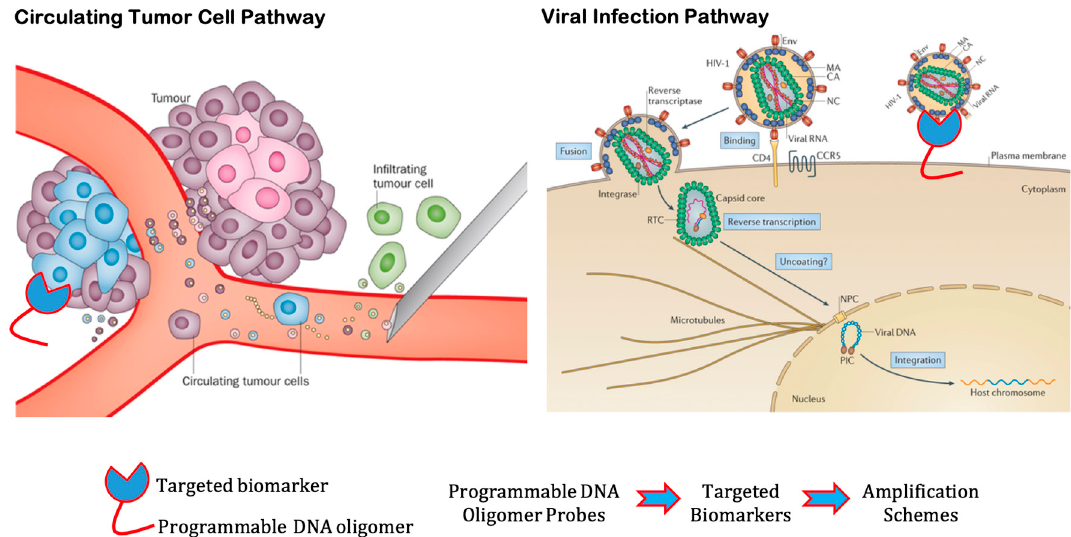
Figure 1. Current challenges in disease detection: ( Left panel ) Circulating tumor cells (CTCs) tend to be very low abundance and low affinity binding. Reagents are insufficient to finding and/or extracting those cells; ( Right panel ) Viral infections are highly specific and time consuming to construct prototypes on-demand. Hence, programmable DNA oligomers labeled with targeted biomarkers with high binding affinity can be exploited to detect and amplify the low abundance CTCs as well as detect and sense other relevant biomarkers such as viral particles. Adapted with permission from